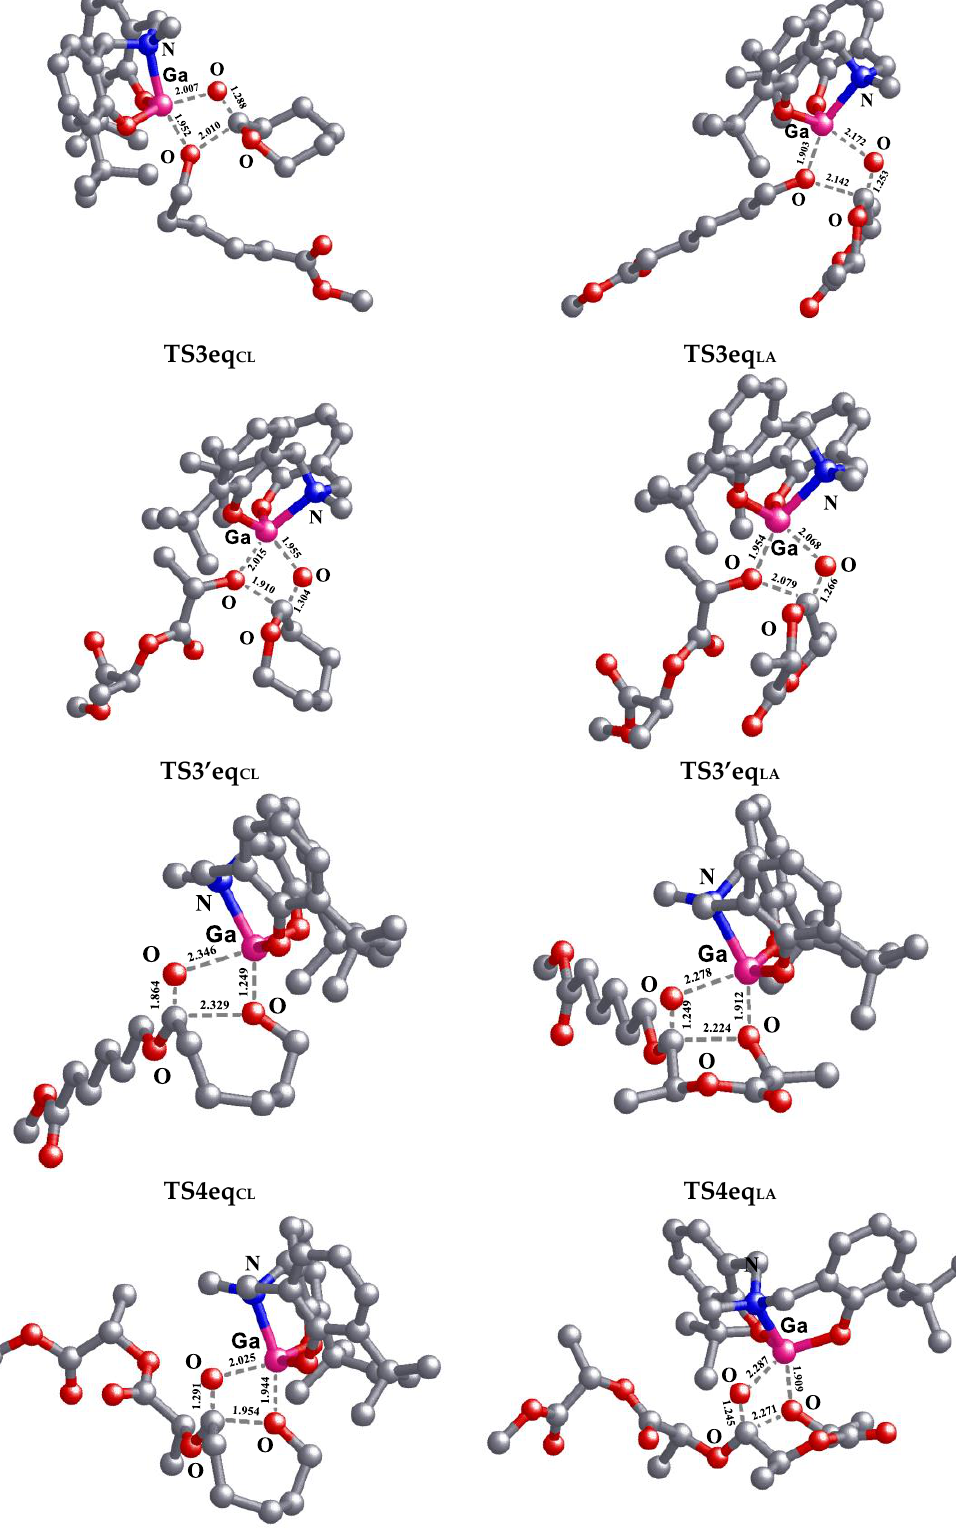
Figure 4. Structures of transition states of first propagation step proceeding via equatorial monomer addition path. Hydrogen atoms are omitted for clarity.